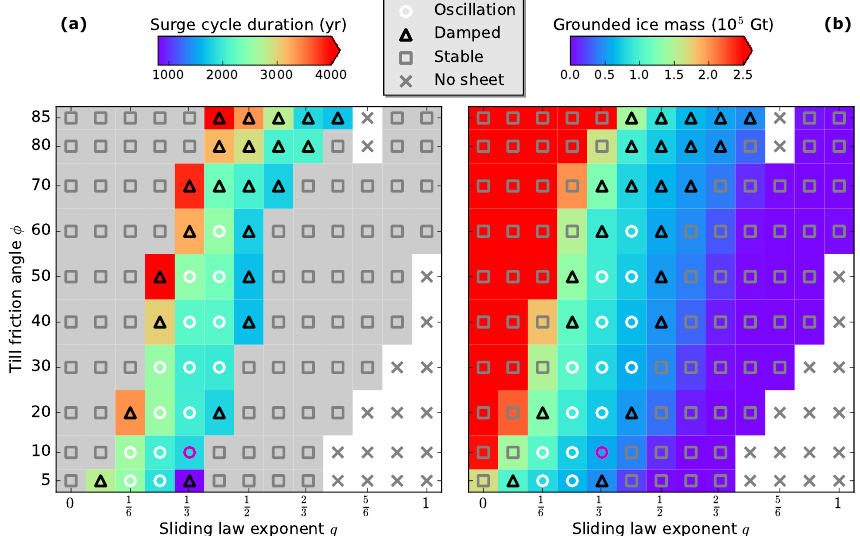
Figure 10. (a) Surge-cycle duration and (b) mean grounded ice mass for the q − φ parameter space. Each colored rectangle represents a simulation characterized by either oscillatory surging (white circles), damped surging (triangles) or stable equilibrium (squares). White rectangles with an “x” denote parameter combinations for which no grounded ice forms inside the bed trough and are thus not considered in the analysis. Since the simulations of stable ice flow do not exhibit periodicity by definition the associated rectangles in panel (a) are colored in gray. The default simulation with parameters of q = 1 / 3 and φ = 10 ◦ is highlighted by a purple circle (see Figs. 3 and A2, gray curve in Figs. 4, 6, 7, 8a and